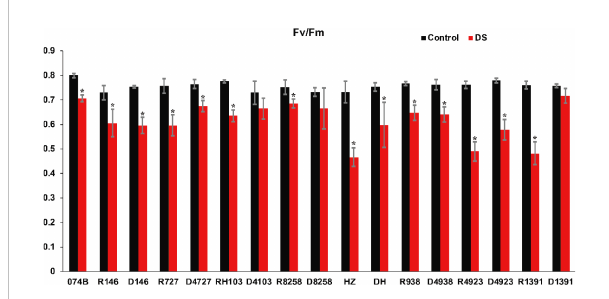
FIGURE 3 Fv/Fm value of restorer lines and hybrid progeny after drought treatment. Fv/Fm represents the maximum quantum ef fi ciency of PSII; DS represents drought stress treatment. Error bars denote standard deviations ( n = 3); “ * ” stands for signi fi cance between drought stress and control condition in the same cultivar (p ≤ 0.05).